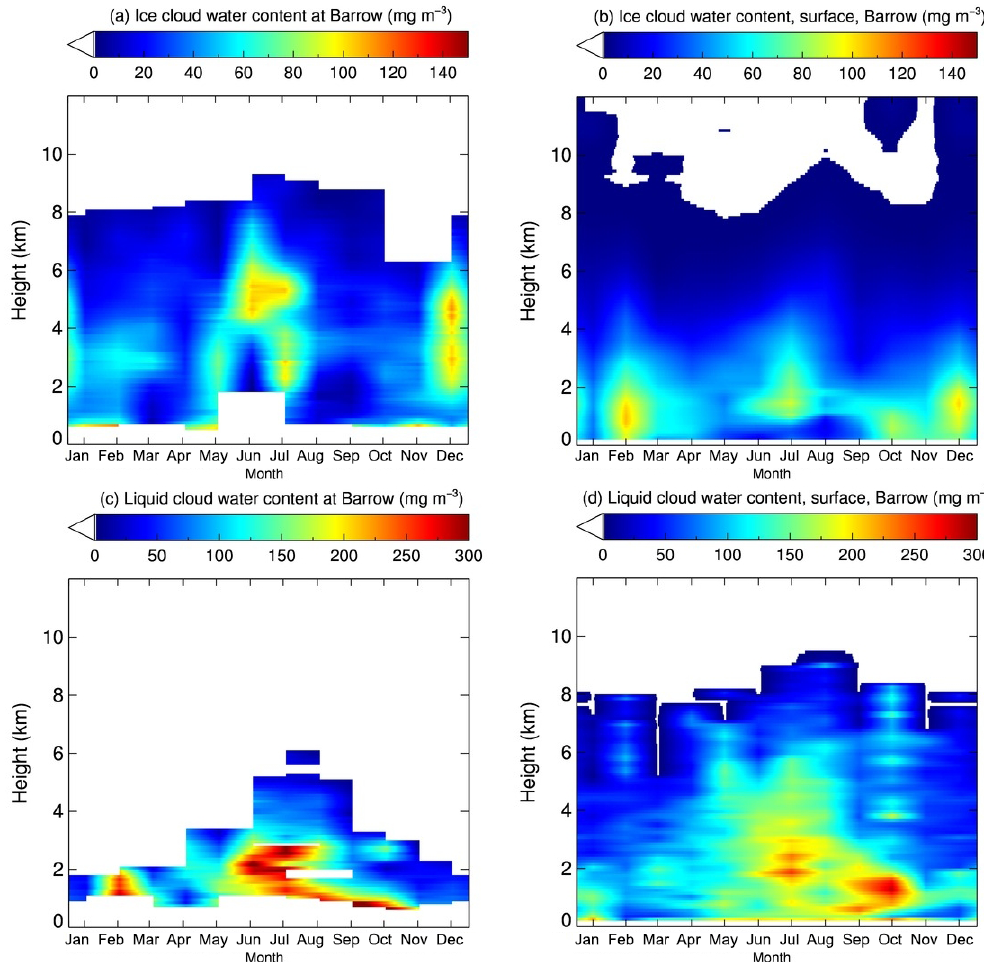
Figure 12. Vertical distributions of cloud water content for ice clouds from (a) 2B-CWC-RO and (b) surface observations, and for liquid clouds from (c) 2B-CWC-RO and (d) surface observations at Barrow for